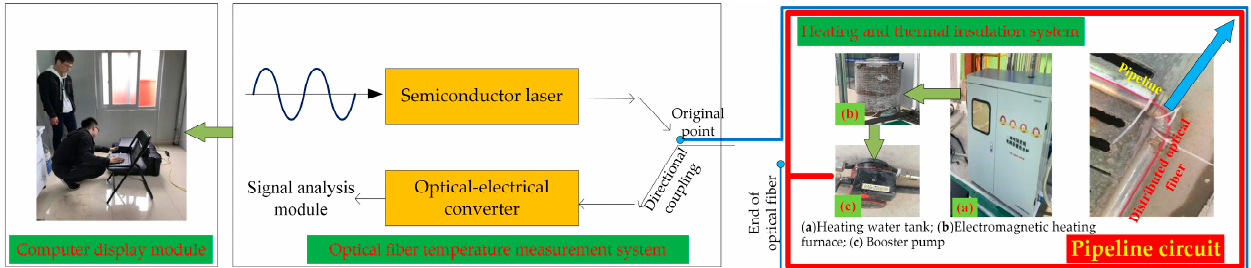
Figure 4. Connection of the ground heating system.